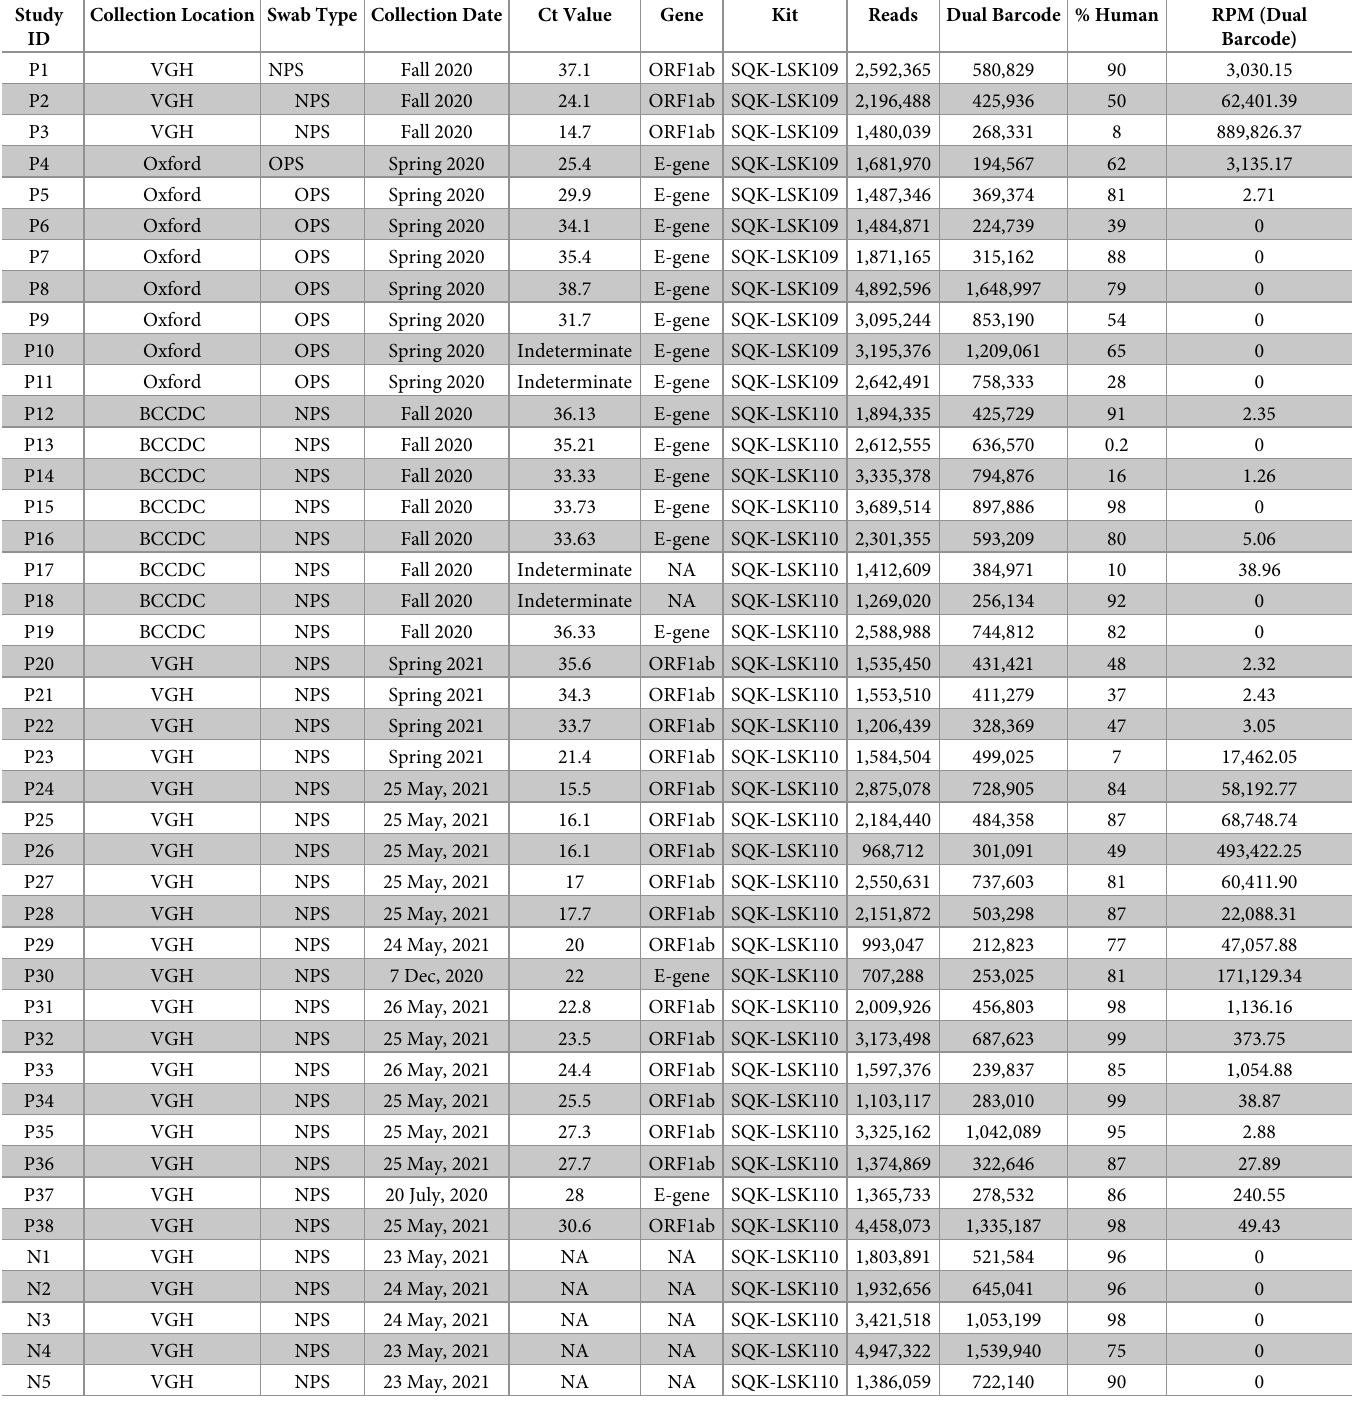
Table 1. Study sample descriptions and sequencing